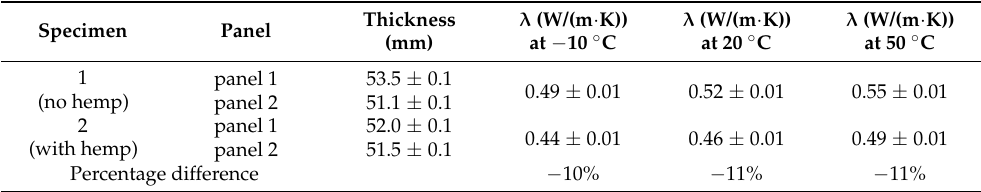
Table 9. Measurement results for thermal